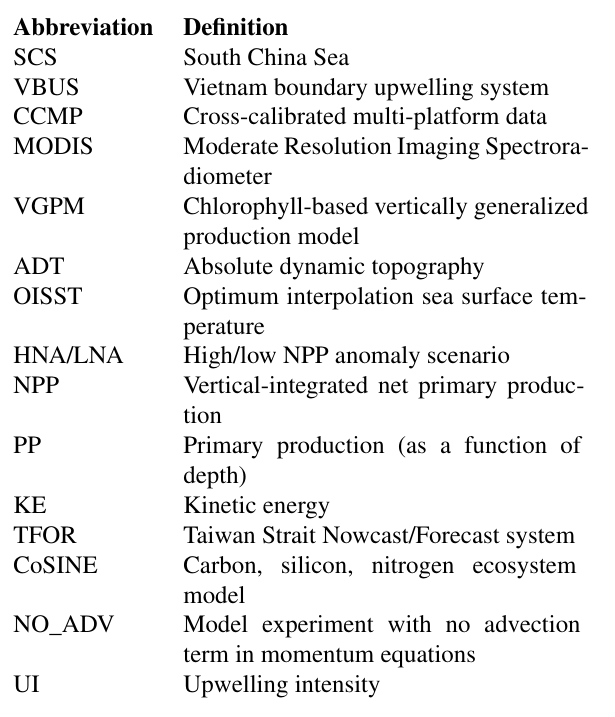
Figure B2. Summer (MJJAS) KE vs. SI averaged over the box re- gion in Fig. B1 (overall R = 0 . 7175, p < 0 .